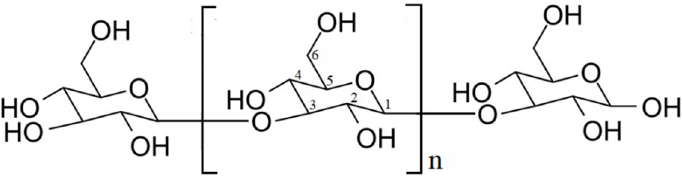
Figure 1. Chemical structure of 1,3- β -D-glucan (curdlan) [3].